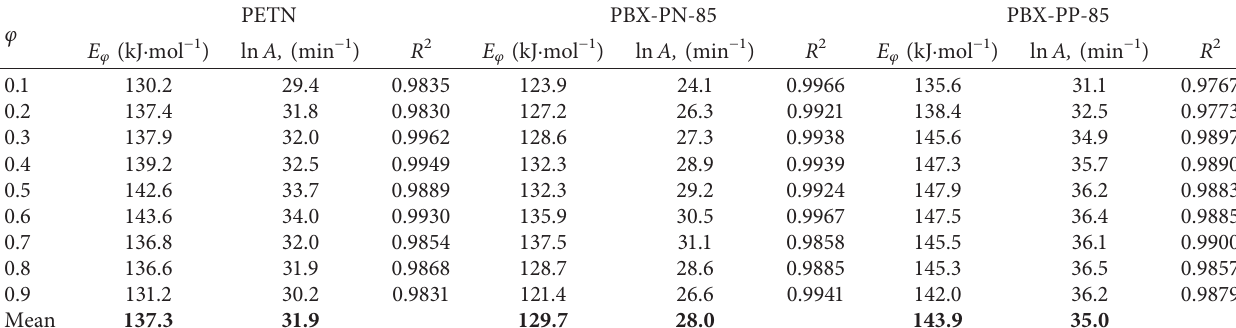
Table 5: Kinetic parameter of PETN and PBXs by the isothermal isoconversional method.